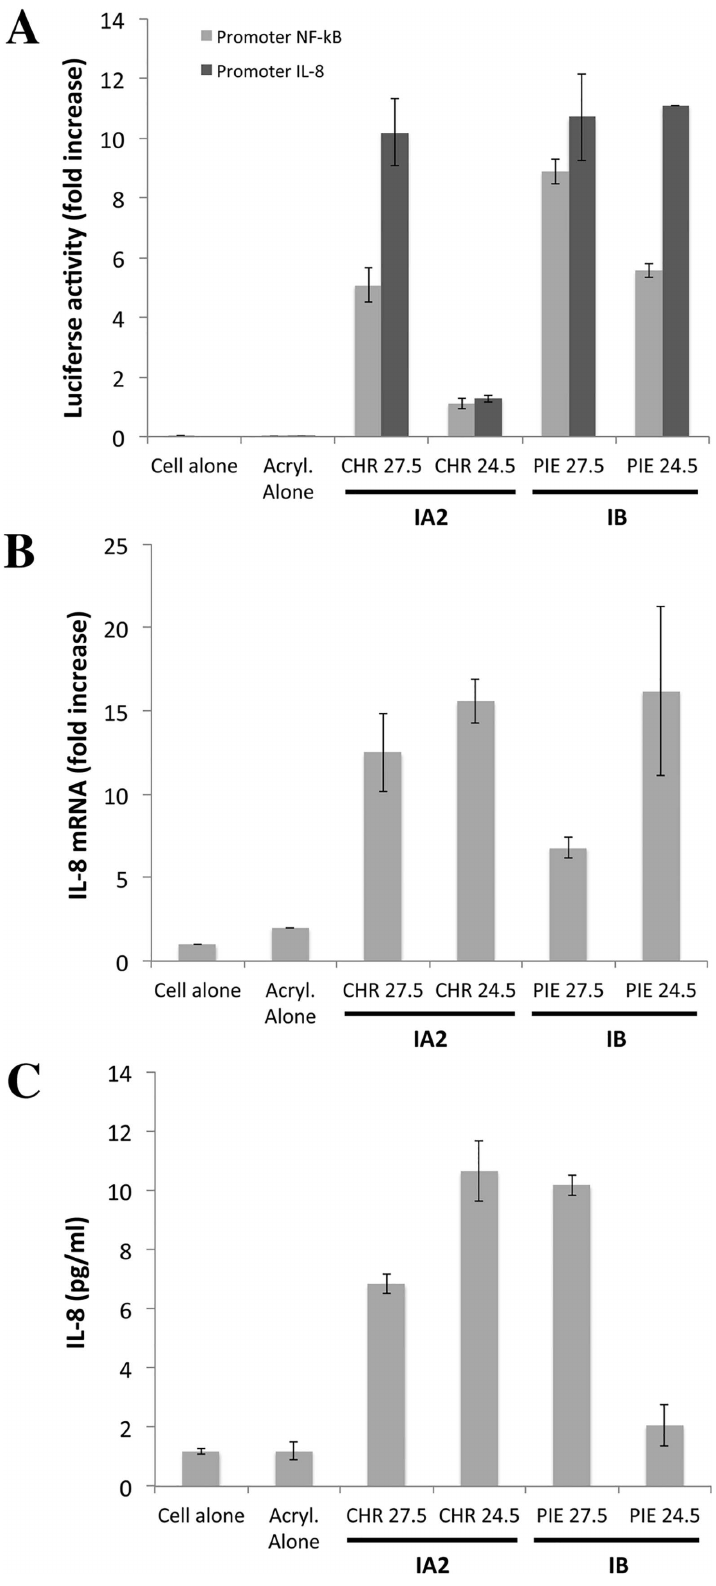
Fig 4. P . acnes surface proteins recognized by TLR2 have proinflammatoryactivity in vitro . Surface proteinextracts were electrophoreticallyseparatedin 10% SDS-PAGE gels (13 x 13 cm), with